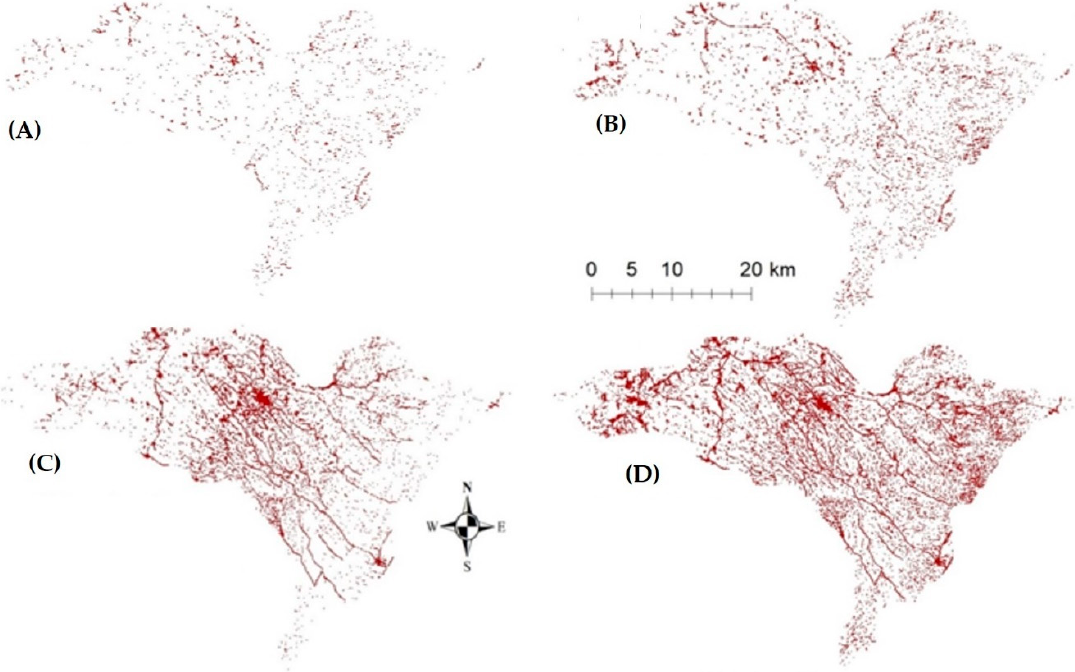
( C ) 2008—2744.28 ha, and ( D ) 2018—3963.60